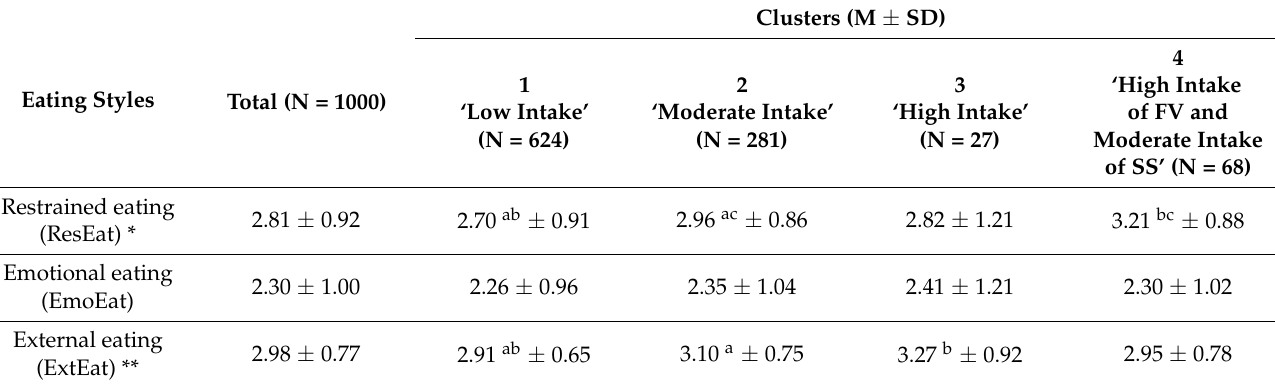
Table 9. Clusters’ profiles according to eating style subscales in the study